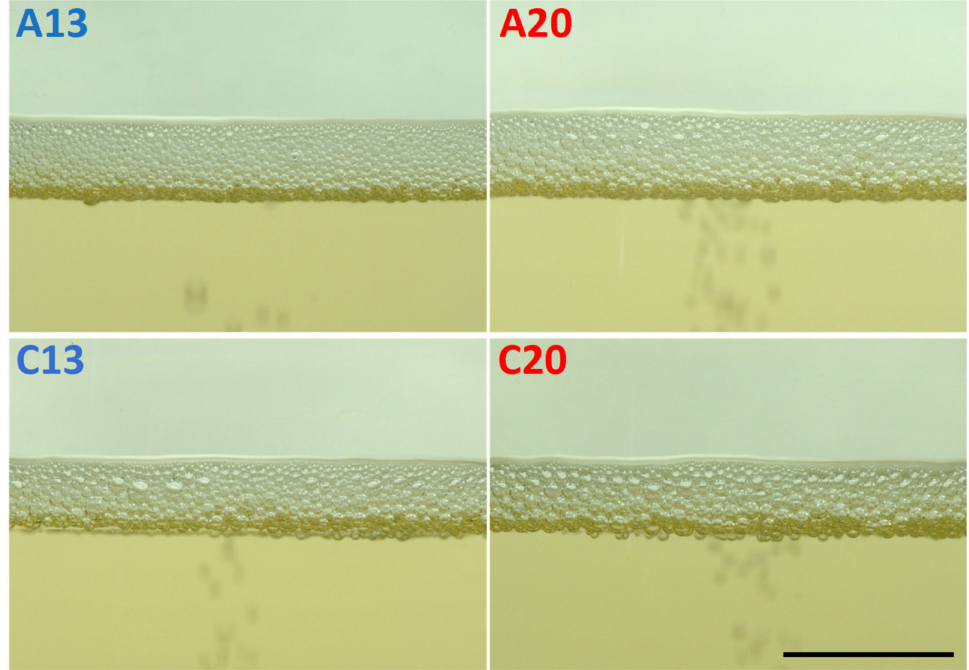
Figure 6. Closeup of the foam collar at 10 min after the end of pouring, from wine samples A and C (bar = 1